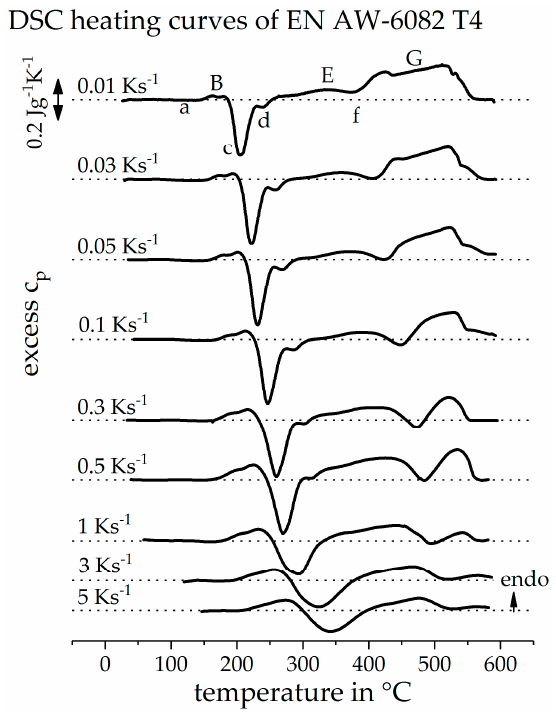
Figure 8. Direct DSC heating curves of EN AW-6082 T4 with the conventional DSC. Peak assignments are stated for the heating rate of 0.01 Ks − 1 .